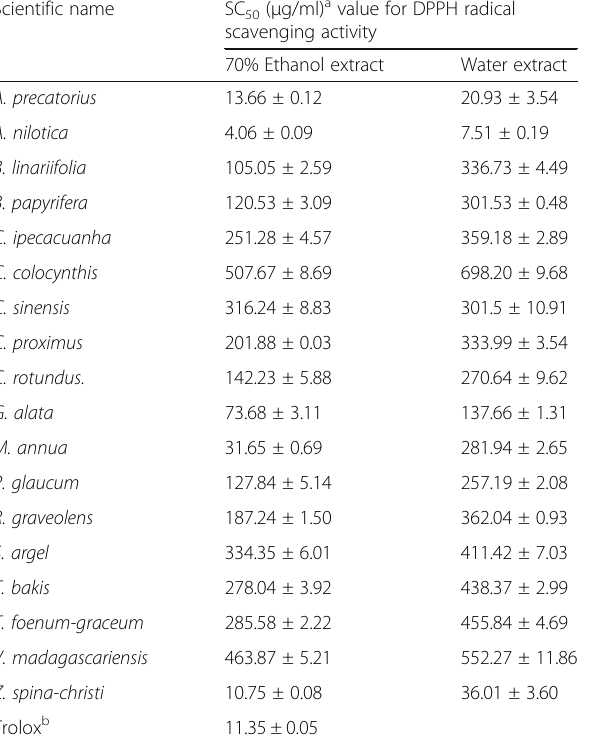
Table 3 DPPH radical scavenging activity of extracts